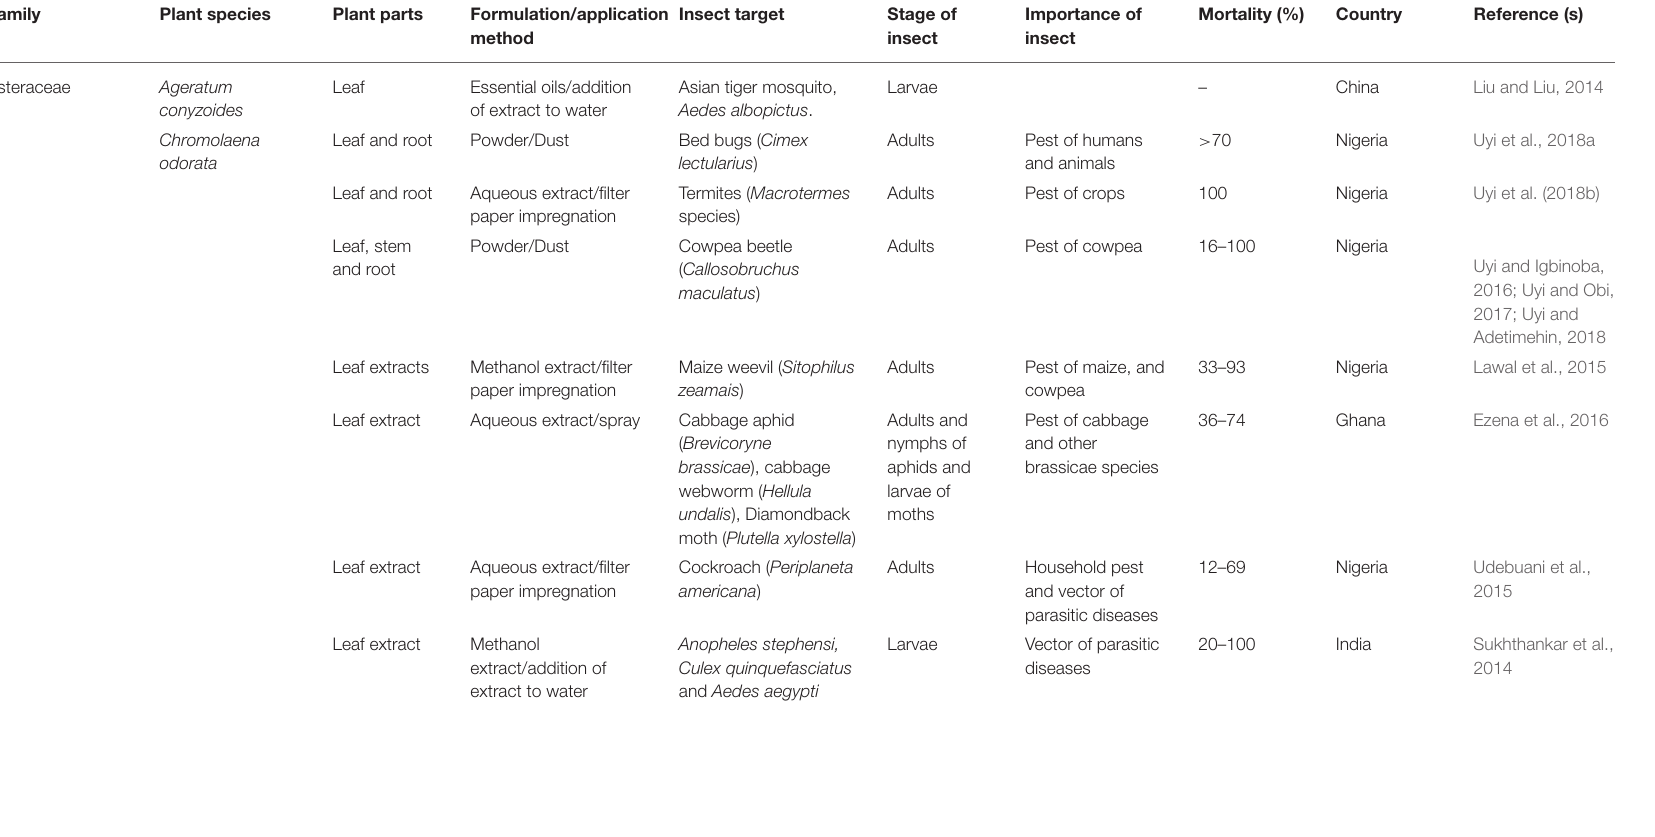
TABLE 2B | Published reports on the insecticidal activities of some plant species with invasive potentials in sub-Saharan